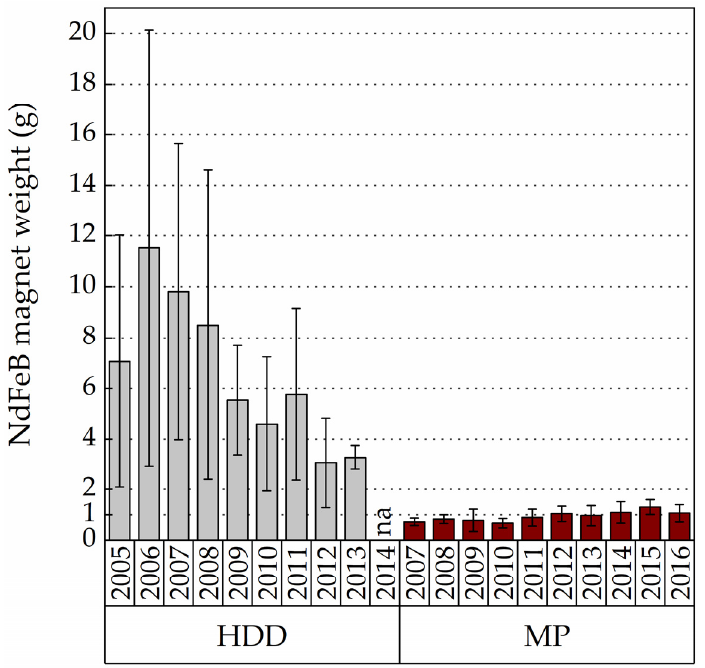
Figure 2. Average NdFeB magnet weight (g) of mobile phones (MPs) and hard disk drives (HDDs) from the years 2005 to 2016, according to the correspondent device lifespan. Note: na = not available.